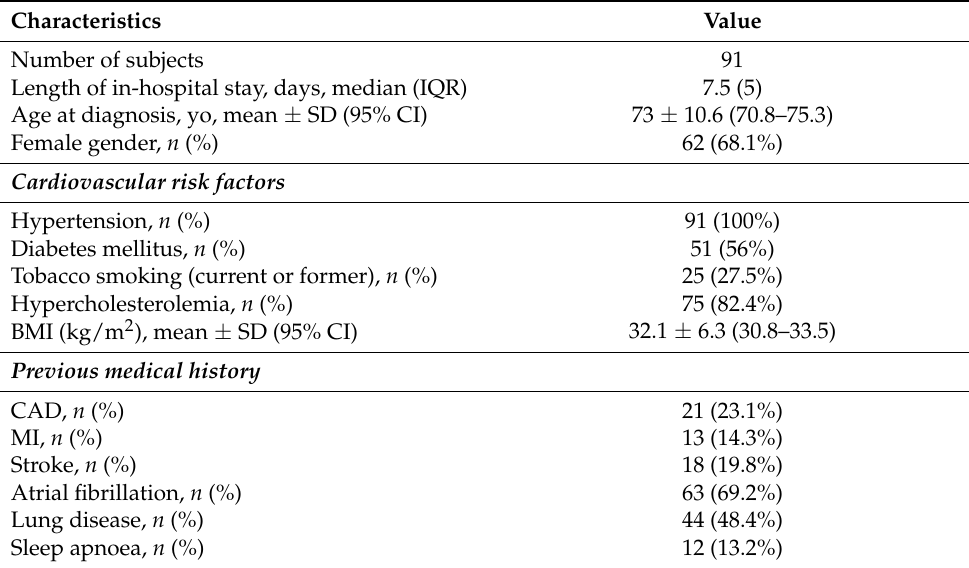
Table 1. Key baseline characteristics of the patients with HFpEF ( n = 91).